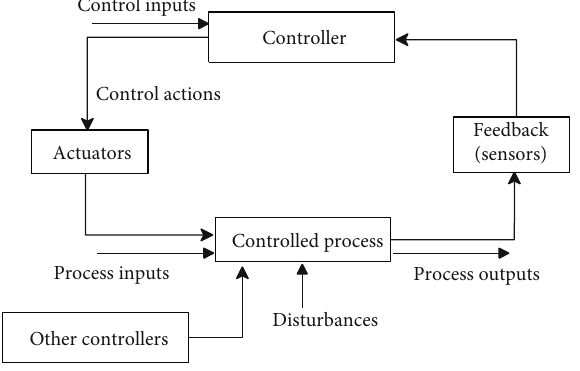
Figure 4: The STAMP control model.